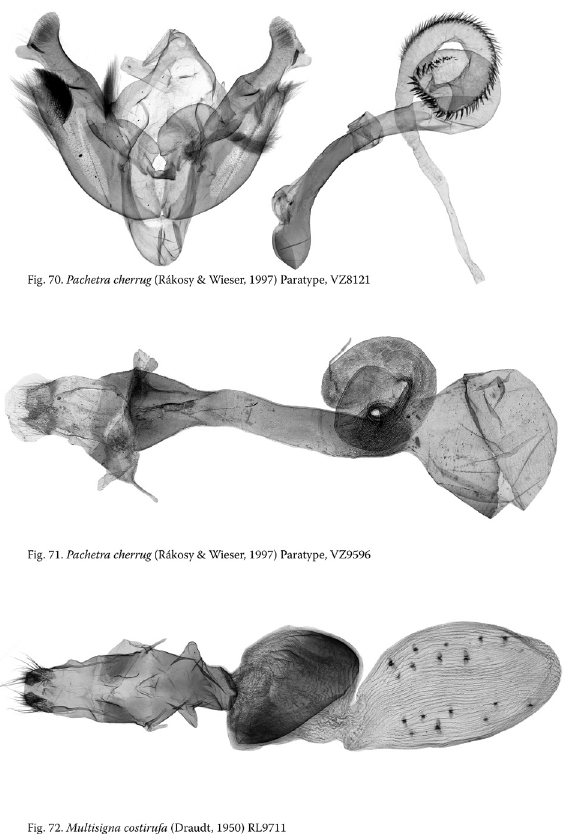
Figure 70–72. 70. Pachetra cherrug (Rákosy & Wieser, 1997) Paratype male. 71. Pachetra cherrug (Rákosy & Wieser, 1997) Paratype female. 72. Multisigna costirufa (Draudt, 1950).